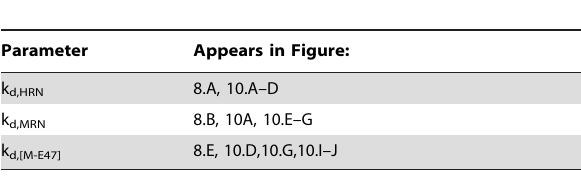
Table 4. Parameters able to mediate neural